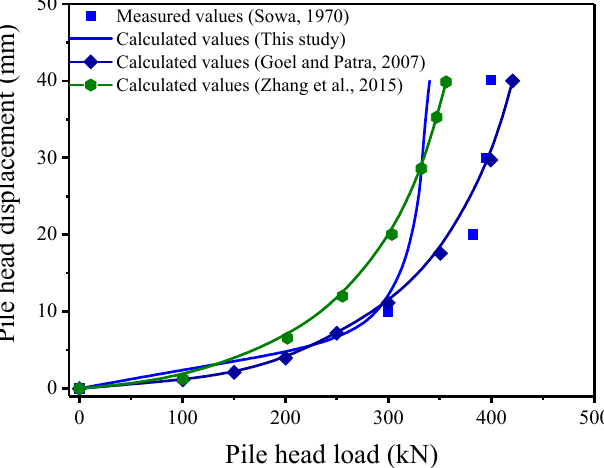
Figure 6. Measured and calculated load-displacement curves of a single uplift pile ([30,33,34]).